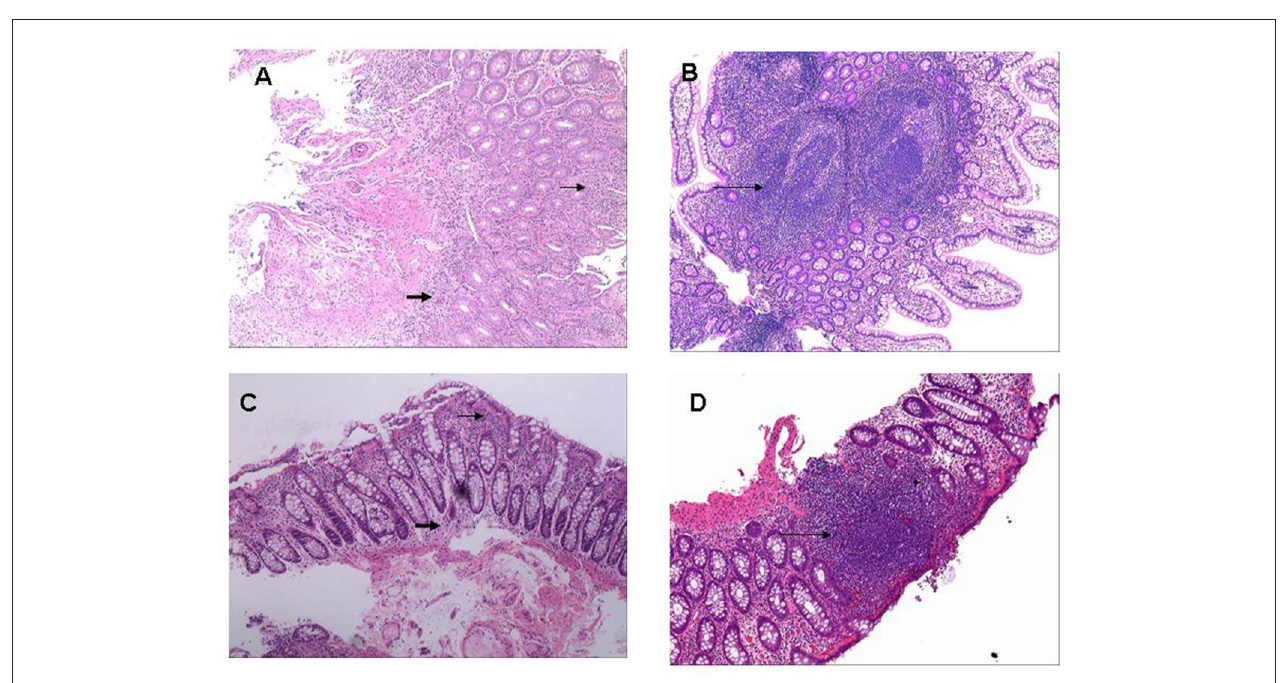
FIGURE 4 | Histopathological pictures of gut inflammation among SpA patients. (A) Histologically infiltration of Inflammatory cells was around gland duct (small arrow) and at underlying submucosa (bold arrow) located in terminal ileum (H&E; original magnification × 10). (B) Multiple ectopic lymphoid tissues were microscopically observed in the terminal ileum (long arrow) with massive infiltration of inflammatory cells around gland duct (H&E; original magnification × 10). (C) Tissue specimen from descending colon demonstrated moderate infiltration of inflammatory cells around gland duct (small arrow) and in the underlying submucosa (bold arrow) (H&E; original magnification × 20). (D) A ectopic lymphoid tissue was microscopically observed at rectum specimen (long arrow) with massive infiltration of inflammatory cells around gland duct (H&E; original magnification × 20).